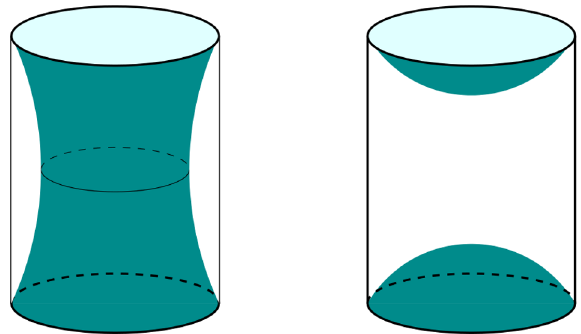
Figure 10. Phases of the 3d ETW brane in the ζ